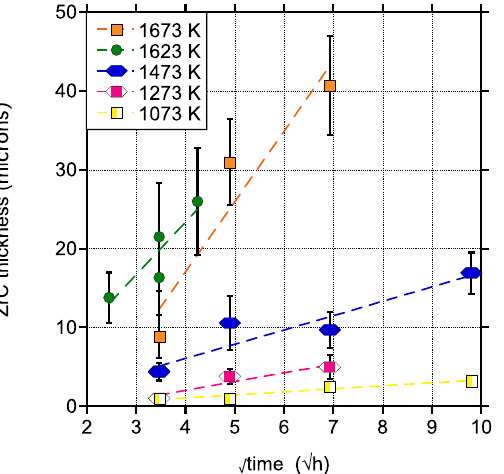
Figure 4. ZrC layer thickness versus the square root of time during the isothermal holds from solid state carburization (1073, 1273, 1473, 1673 K) and pack carburization (1623 K). Table 2. K p and A values as a function of temperature based on the data presented in Figure